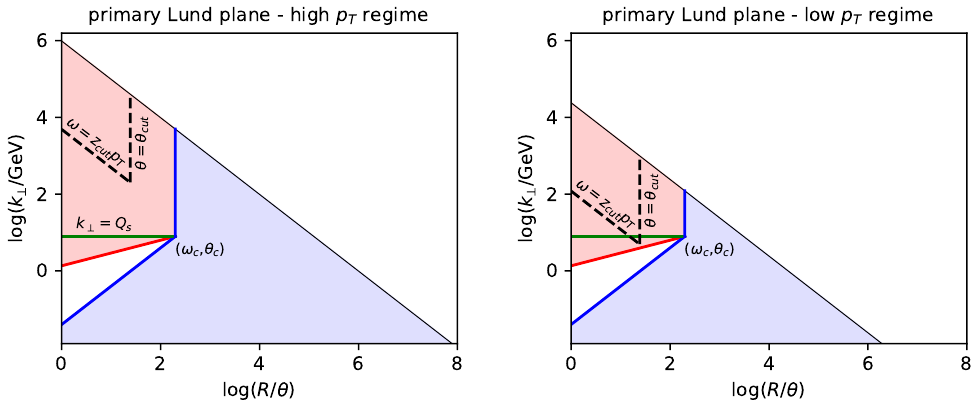
Figure 9 . The kinematic regions in the Lund plane that are covered by the SD algorithm in the case of a high-energy jet ( z cut p T > ! c ) in the left (cid:12)gure and of a low-energy jet ( z cut p T < ! c ) in the right (cid:12)gure. As suggested by the pictorial representation in the right (cid:12)gure, the most interesting situation for \low-energy jets" is such that there is only little overlap between the kinematic region for SD and the phase-space for